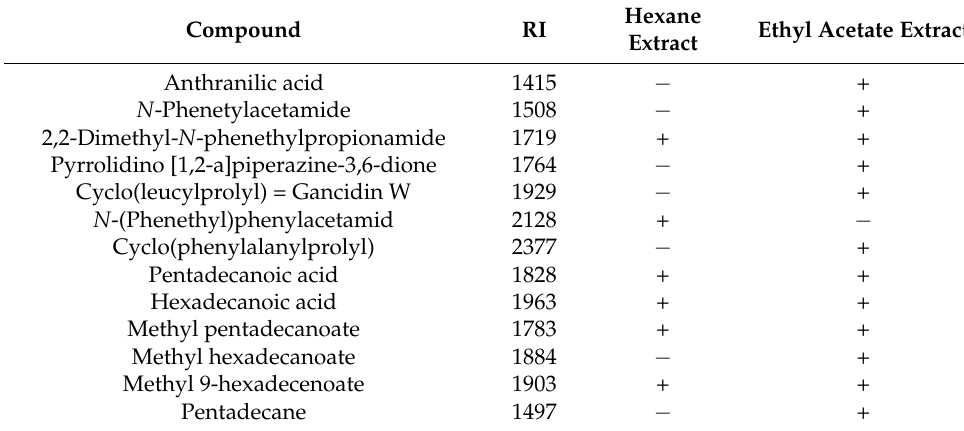
Figure 2. Endophytic bacteria isolated from Marchantia polymorpha L. ( a ) Gram straining (Gram- positive bacteria) and ( b ) Endophytes on solid Columbian agar medium. Table 2. The list of the compounds identified in the endophytic microorganisms of Marchantia polymorpha L.; RI-retention index on ZB-5